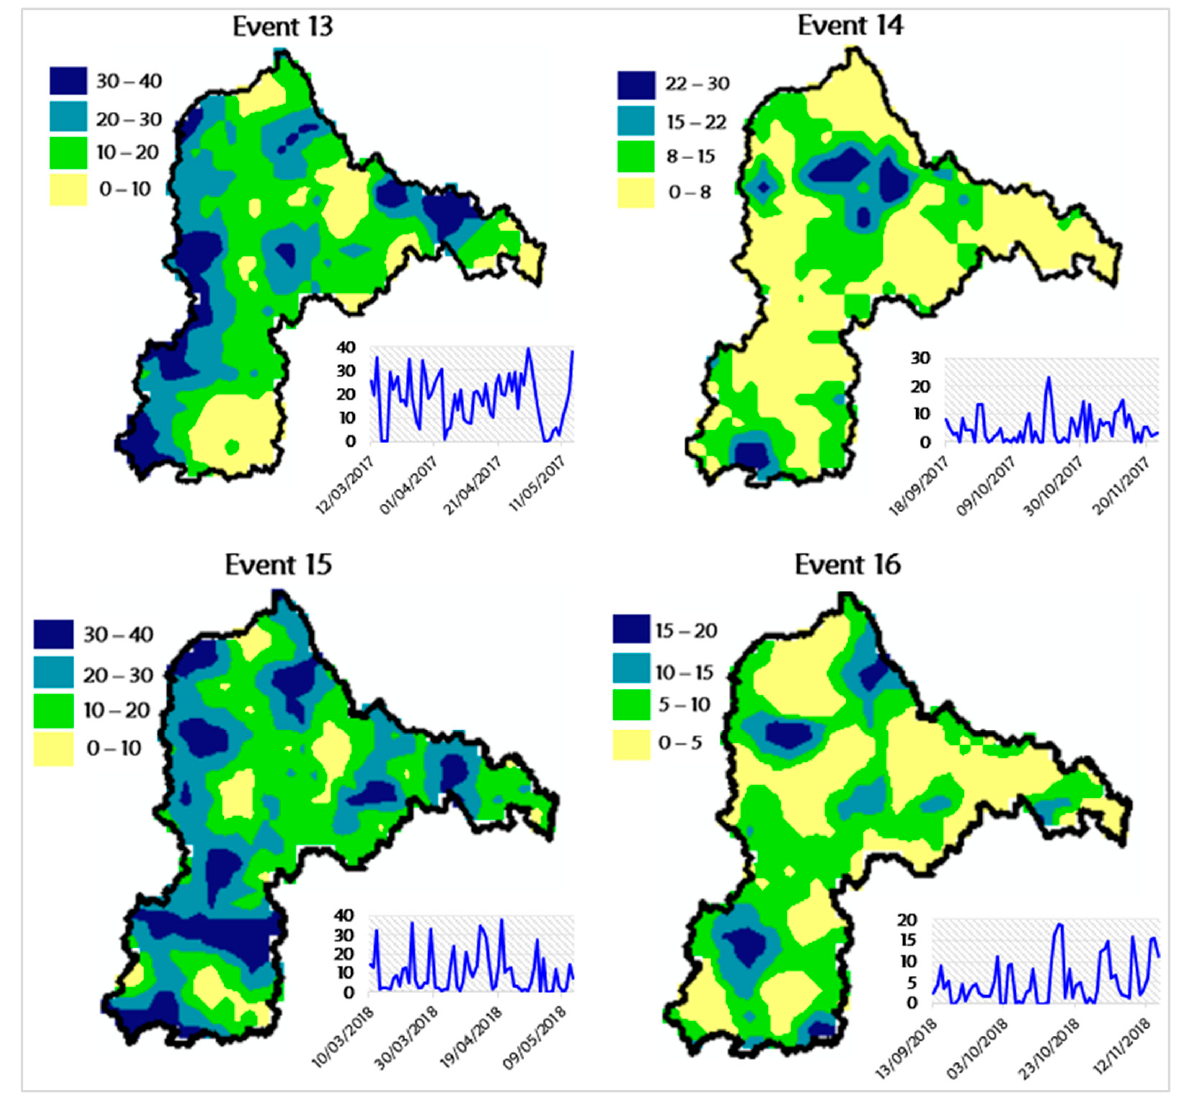
Figure 7. Rainfall hyetographs distribution per event.